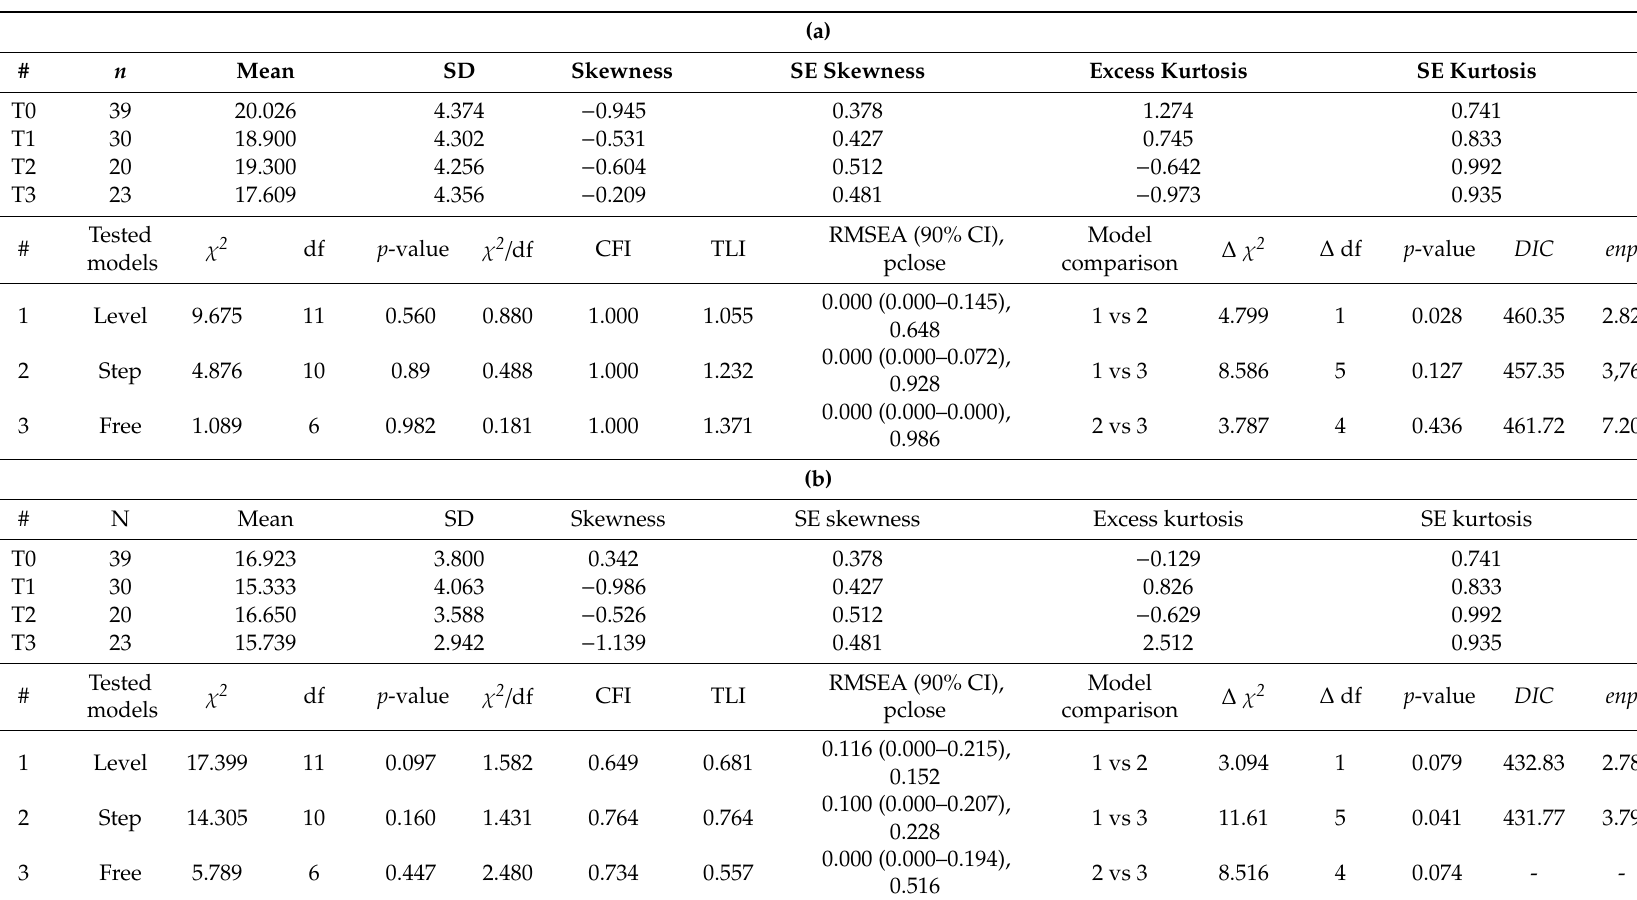
Table 2. ( a )Comparisons of latent growth curve models estimating growth trajectory for the representation of a personal control of PD over an 18-month follow-up (T0–T3). ( b ) Comparisons of latent growth curve models estimating growth trajectory for the representation of a control of PD by treatment over an 18-month follow-up